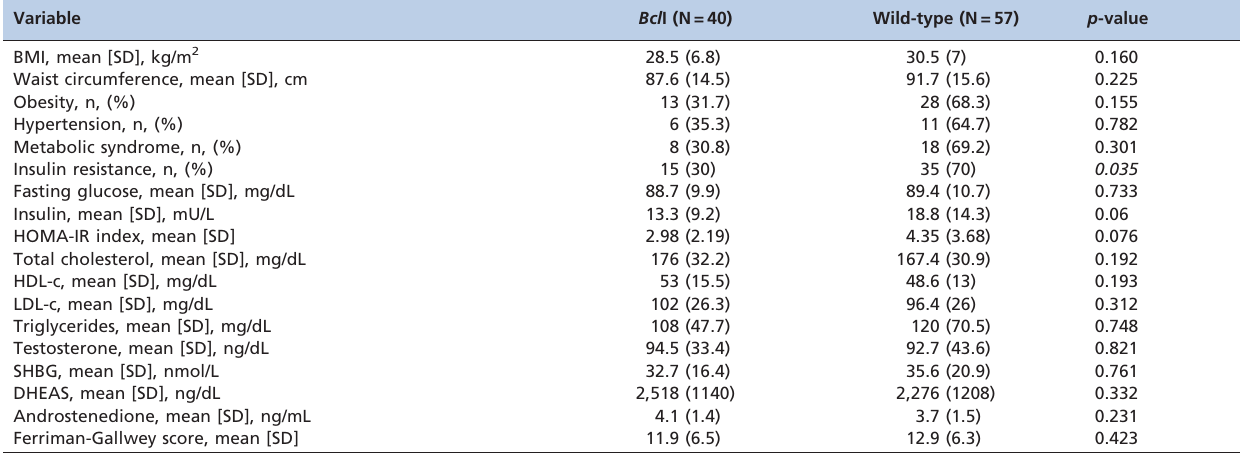
Table 2 - Influence of the Bcl I polymorphism on the clinical, hormonal and metabolic profiles of patients with polycystic ovary syndrome.